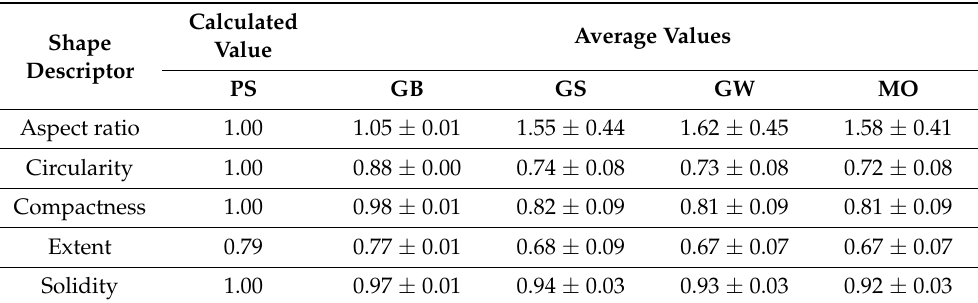
Table 5. Summary of the physical properties of the selected materials. Packing Material Property GB GS GW